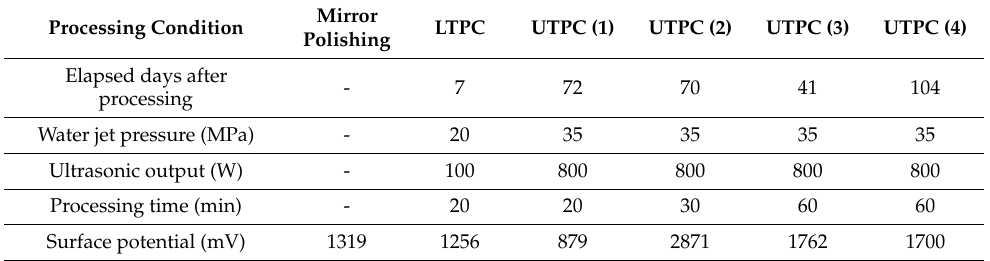
Table 2. Surface potential of aluminum alloy (AC4CH) by various processing. Processing Condition